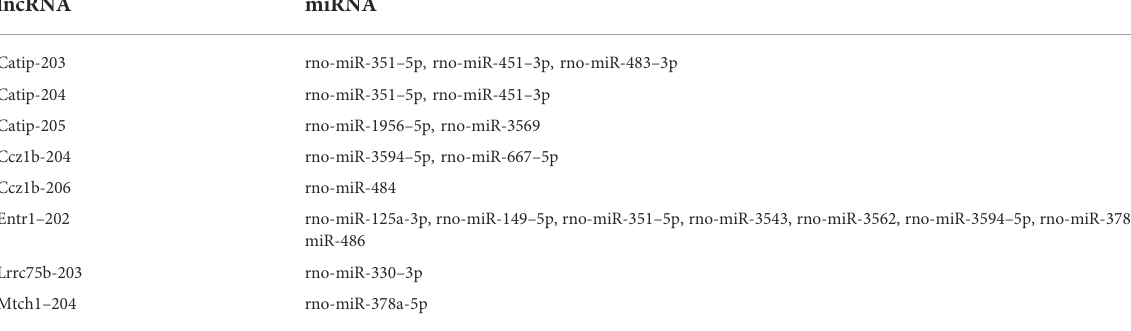
TABLE 1 The top 8 lncRNAs predicted based on their involvement in the interaction between HNRNPA2B1 and miRNAs. lncRNA